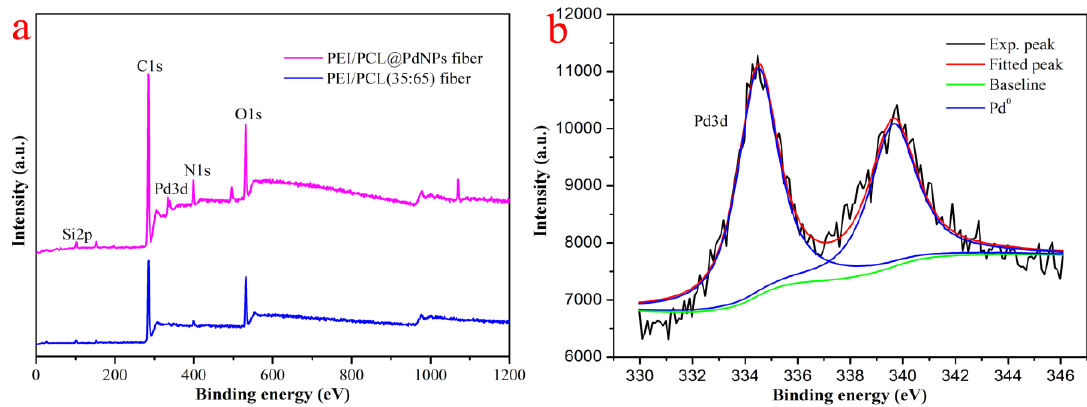
Figure 7. Survey X-ray photoelectron spectroscopy (XPS) spectra of the obtained PEI / PCL fiber and PEI / PCL@PdNPs ( a ) and deconvolutions of XPS peaks of the Pd3d region ( b ).